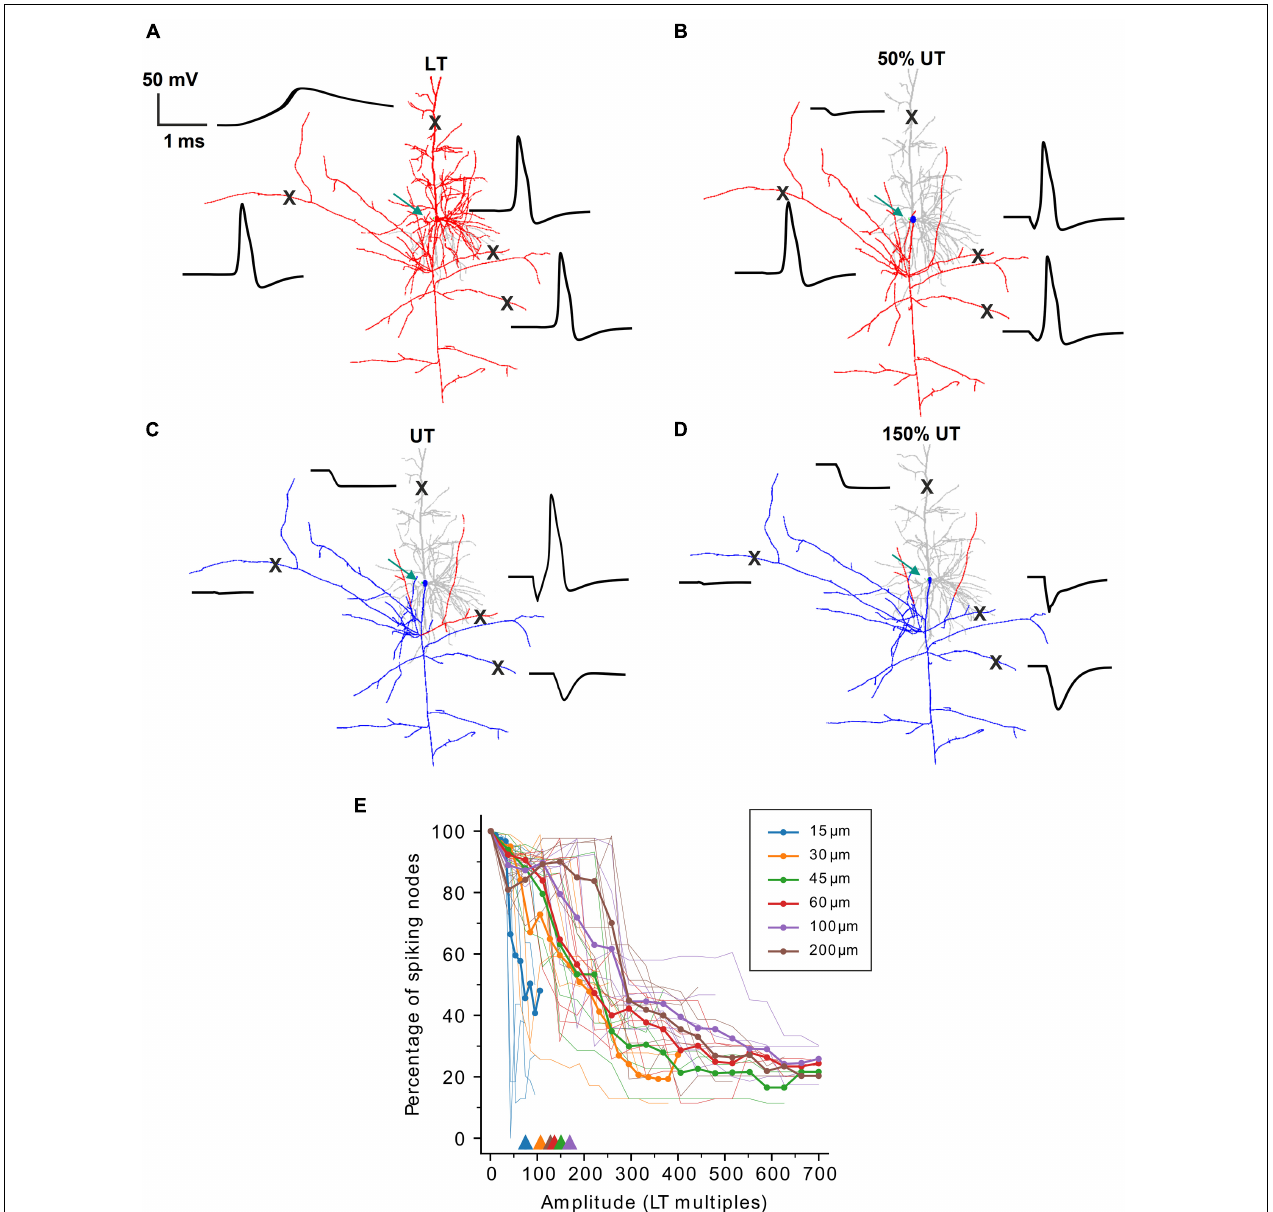
FIGURE 3 | Partial spiking activity during high-amplitude stimulation in PCs. (A) Neuron shape plot showing portions along the neural membrane which generated an AP (red) and that were not excited (gray) when stimulated at LT. Membrane voltage over time (black) is shown for four locations (“X”) along the PC. (B–D) Similar as panel (A) but for amplitudes of 50% UT (B) , UT (C) , and 150% UT (D) , respectively. Regions with an AP are shown in red, regions without an AP in gray (dendrites) or blue (axon and soma). Green arrows indicate the electrode location 15 µ m distant to the soma. (E) The percentage of spiking nodes of Ranvier is plotted against stimulus amplitude (in multiples of LT) for all six investigated electrode distances. Thin lines indicate the spiking node percentage for single cells, thick lines indicate population means. Triangles show the mean thresholds ratios from Figure 2D for different electrode distances.